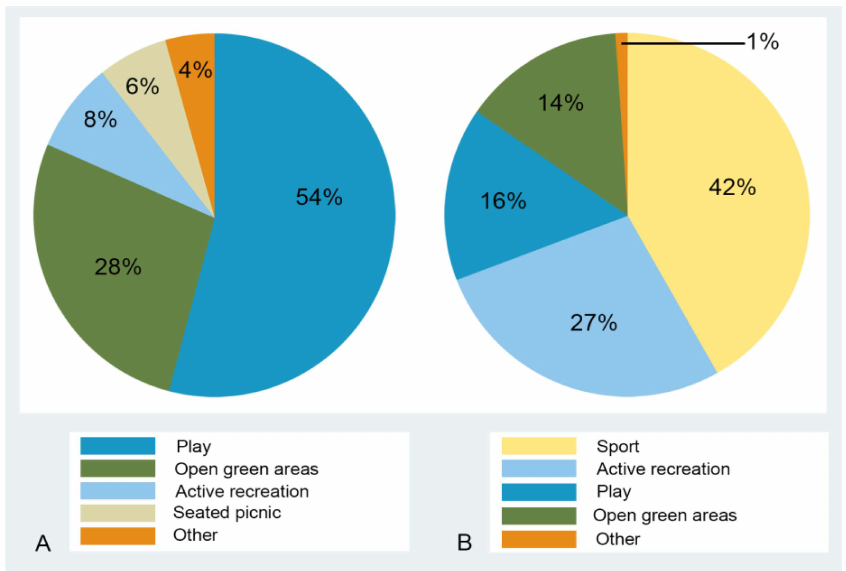
Figure 3. Use of park facilities in ( A ) Green Point Park ( n = 2135) and ( B ) Valhalla Park family Recreation Centre ( n = 1111).